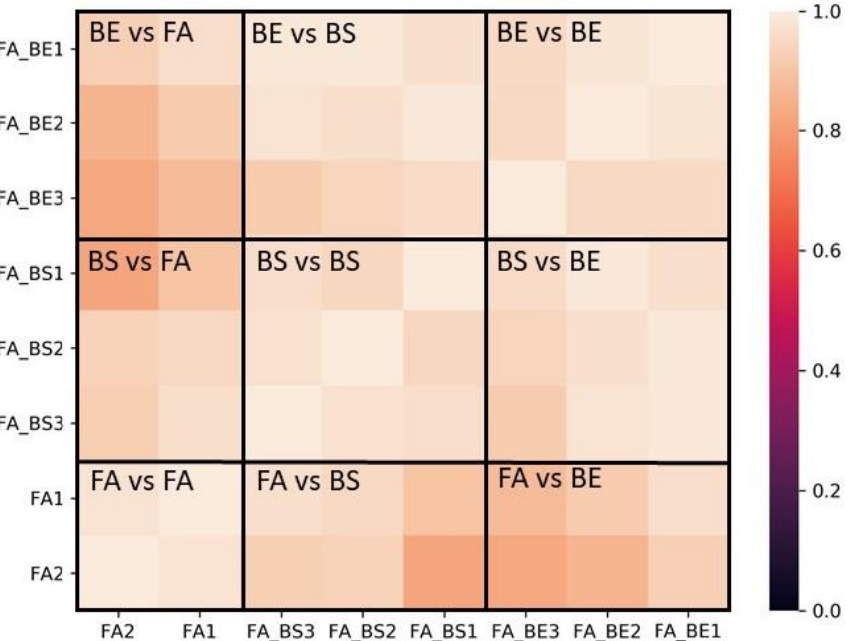
Figure 5. The heatmap for the values of Cell Correlations (R 2 ) calculated for each pair of the samples used in this study. The color bar refers to the value of the Cell Correlations (R 2 ). The heatmap is divided into blocks corresponding to the number of samples in each set: FA_BE (Bond Elut PPL, 3 samples), FA_BS (Bondesil PPL, 3 samples), and FA (2 samples).